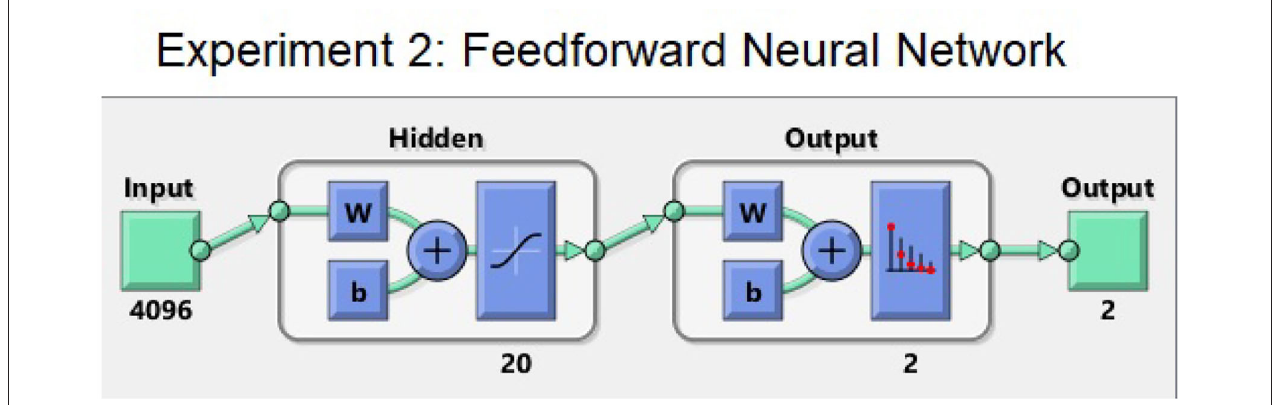
FIGURE 9 | The feedforward fully connected network used in Experiment 2 (FNN 2 ) The full description of the scheme is given in the itemized list in section